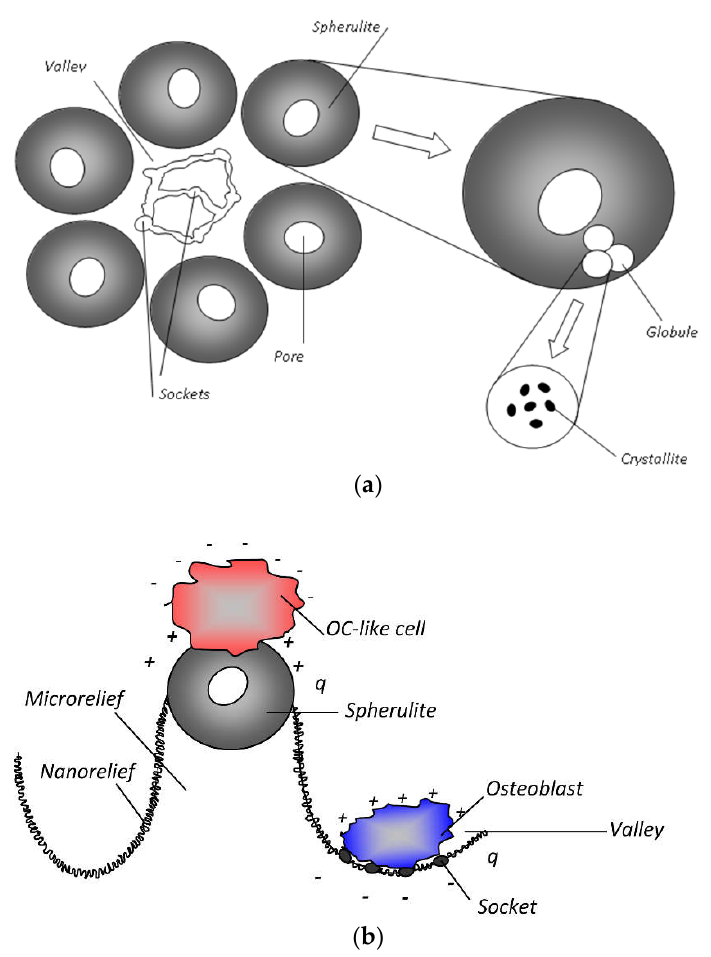
Figure 17. Schematic image of structural elements of the MAO CP coating ( a ) and nonuniform differentiation of cells in HLPSC culture ( b ). OC, osteoclast.